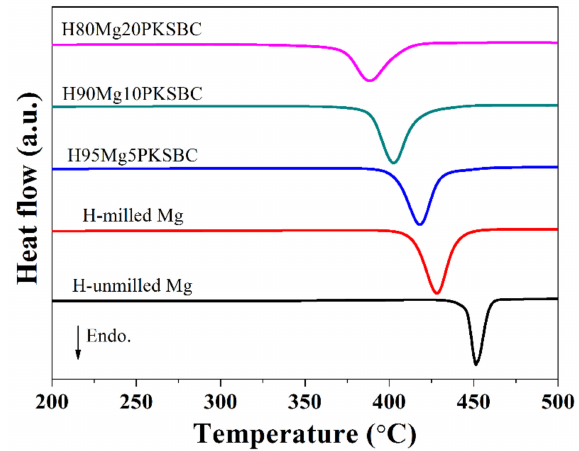
Figure 10. DSC curves of hydrogen storage materials at a heating rate of 10 ◦ C /